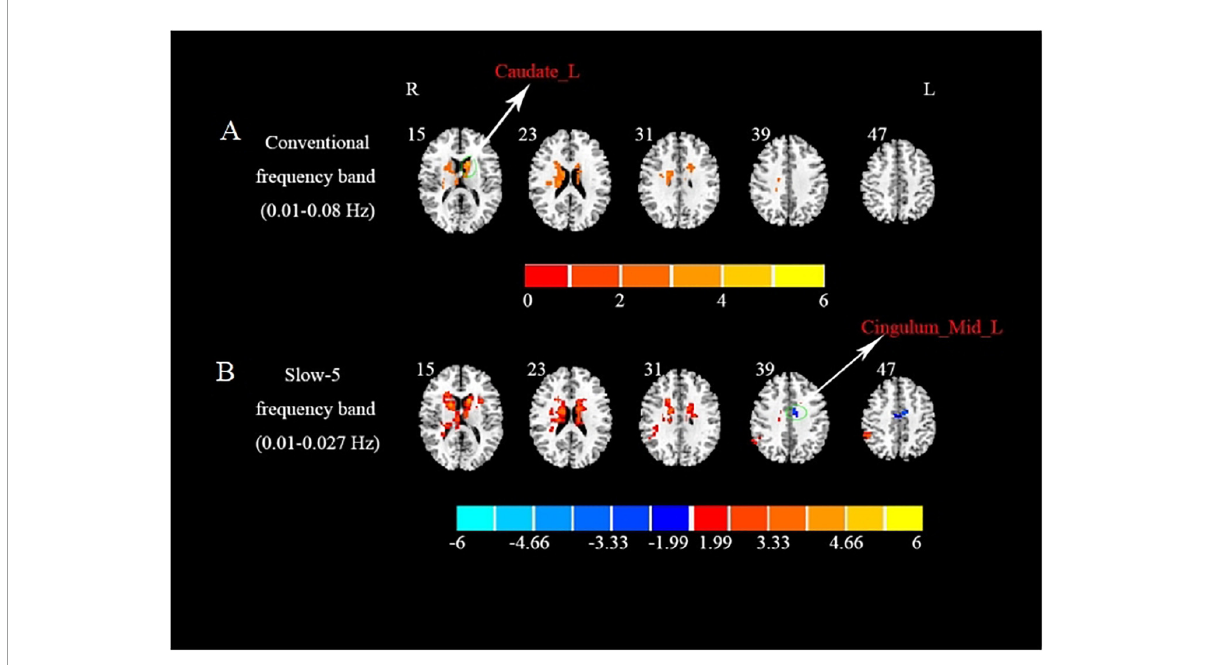
FIGURE1 Brain regions with significant differences in ReHo in three different frequency bands between BGIS and HCs groups. (A) Brain regions with differences in ReHo in conventional frequency band. (B) Brain regions with differences in ReHo in slow-5 frequency band. R, right hemisphere; L, left hemisphere; BGIS, basal ganglia ischemic stroke; HCs, healthy controls; Caudate_L, left caudate; Cingulum_Mid_L, left medial